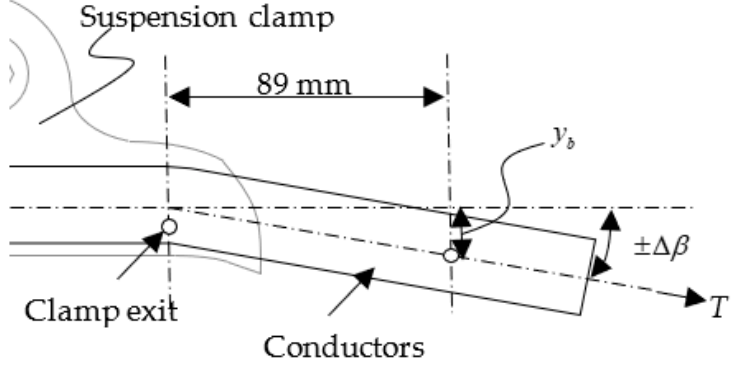
Figure 21. Standardized conductor dynamic bending amplitude measurement.